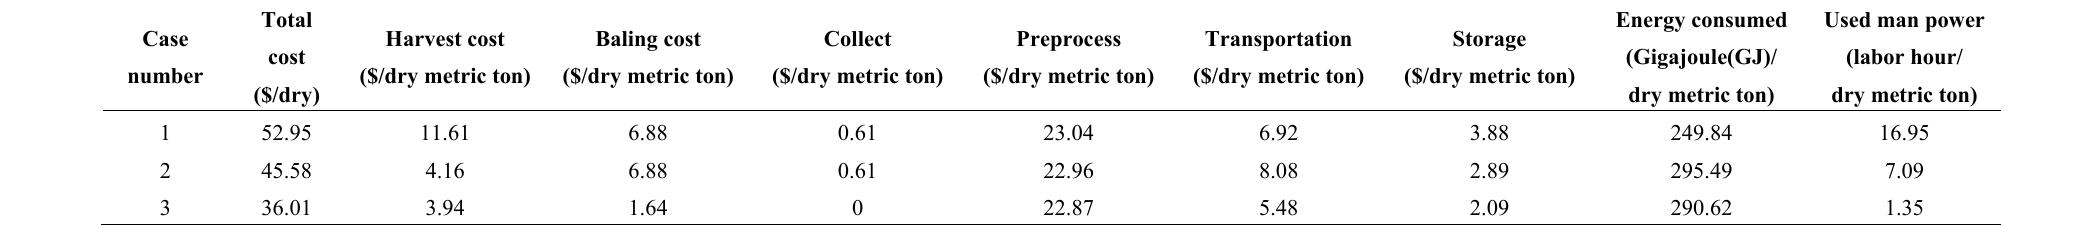
Table 1. 2011 logistics costs for corn stover in Heilongjiang China.